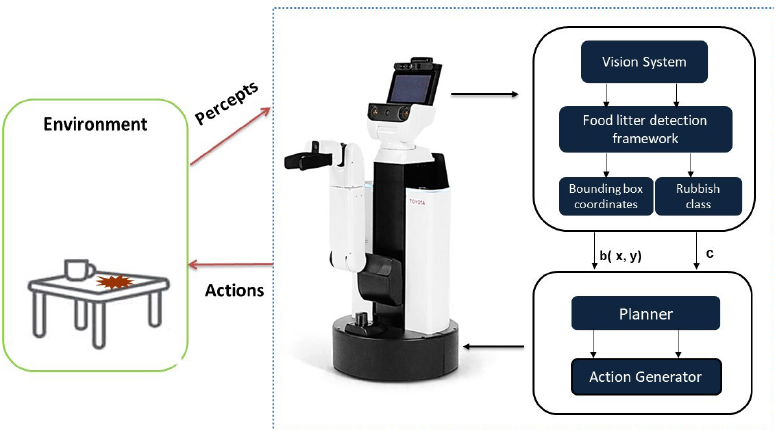
Figure 1. Block diagram of proposed scheme.